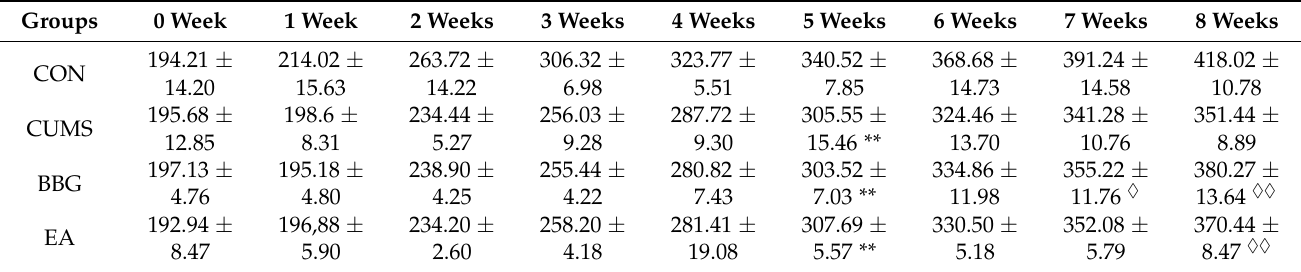
Table 3. Effects of EA on the body weight (n = 10; x ± s;